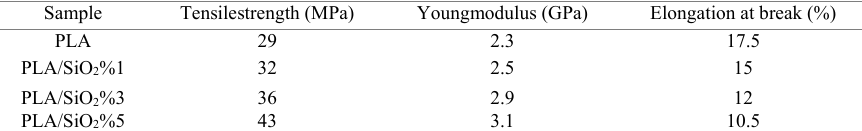
Table 1. Mechanical properties of poly lactic acid and its nanocomposite films